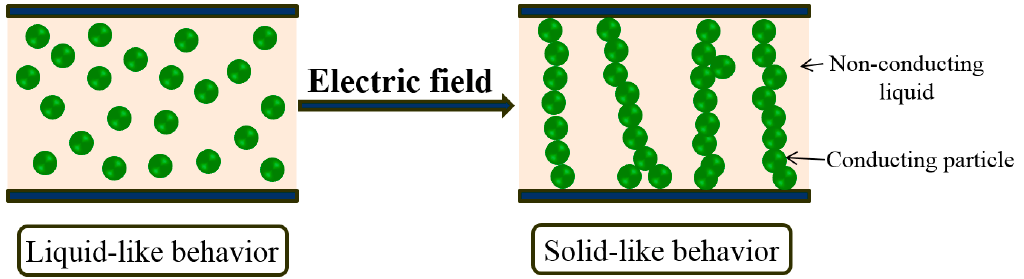
Figure 5. Schematic diagram depicting phase transformation behavior of ER fluid under an applied electric field.